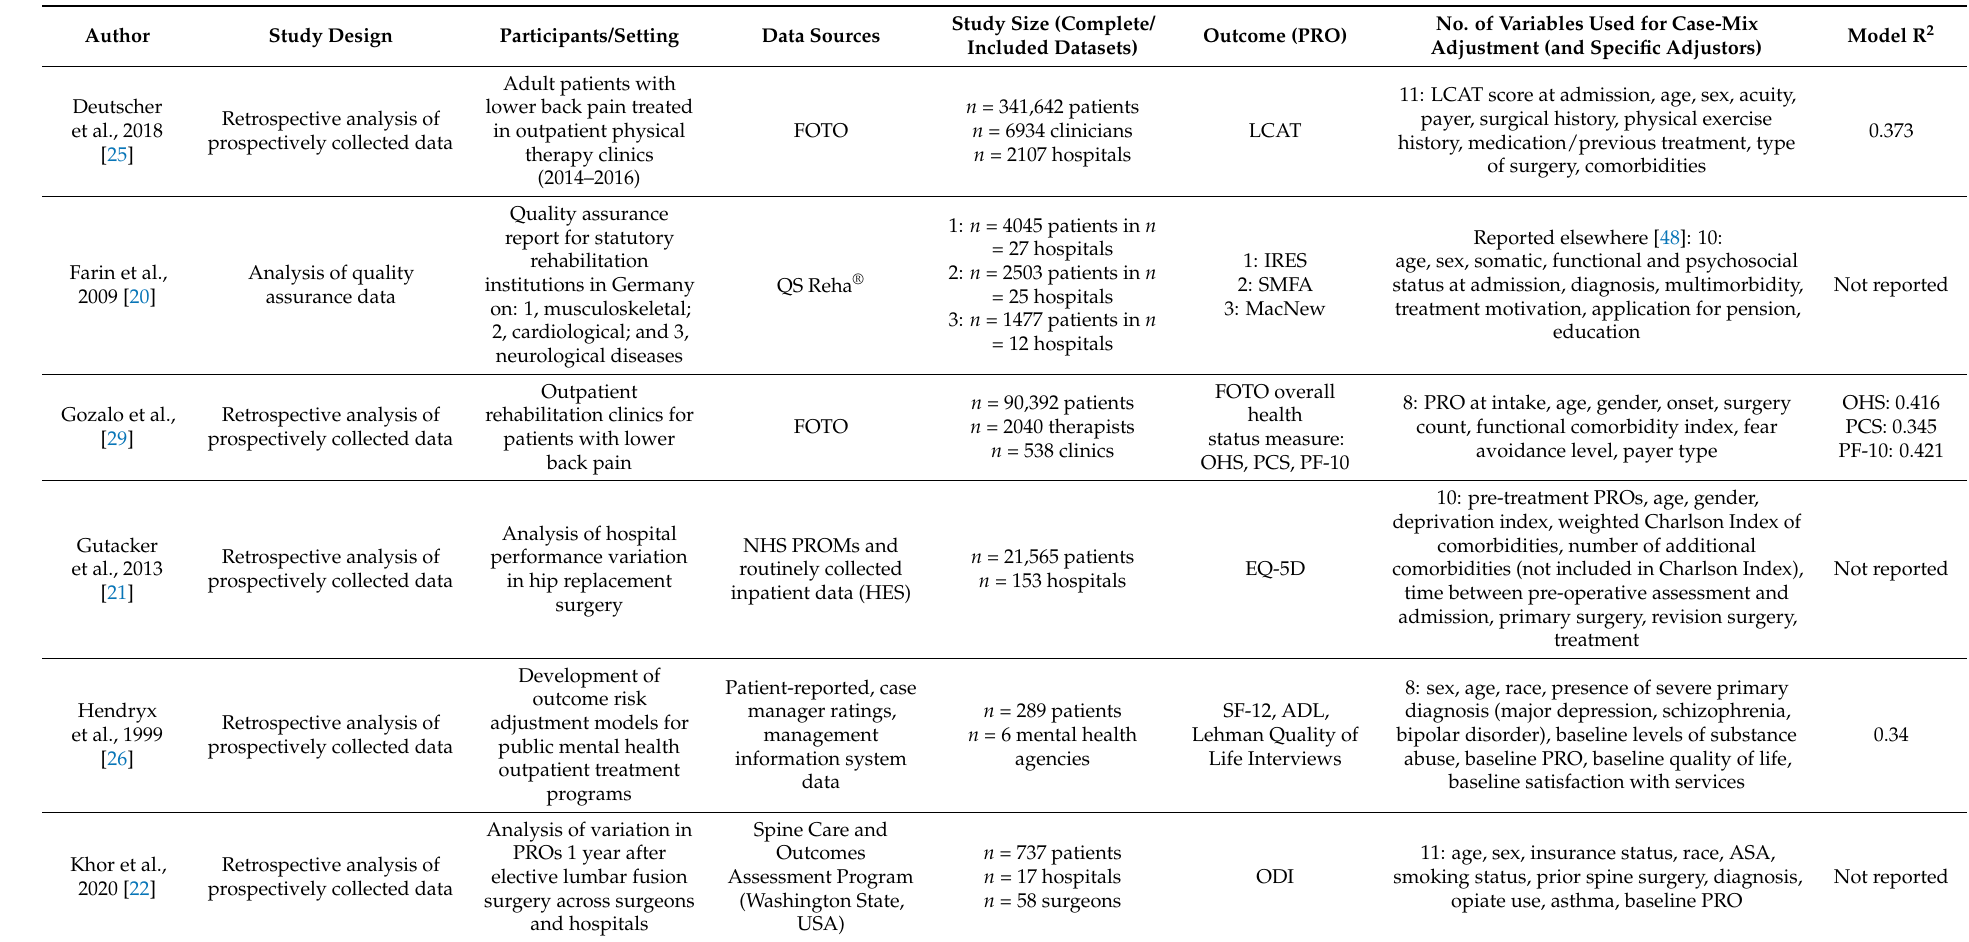
Table 1. Characteristics of eligible